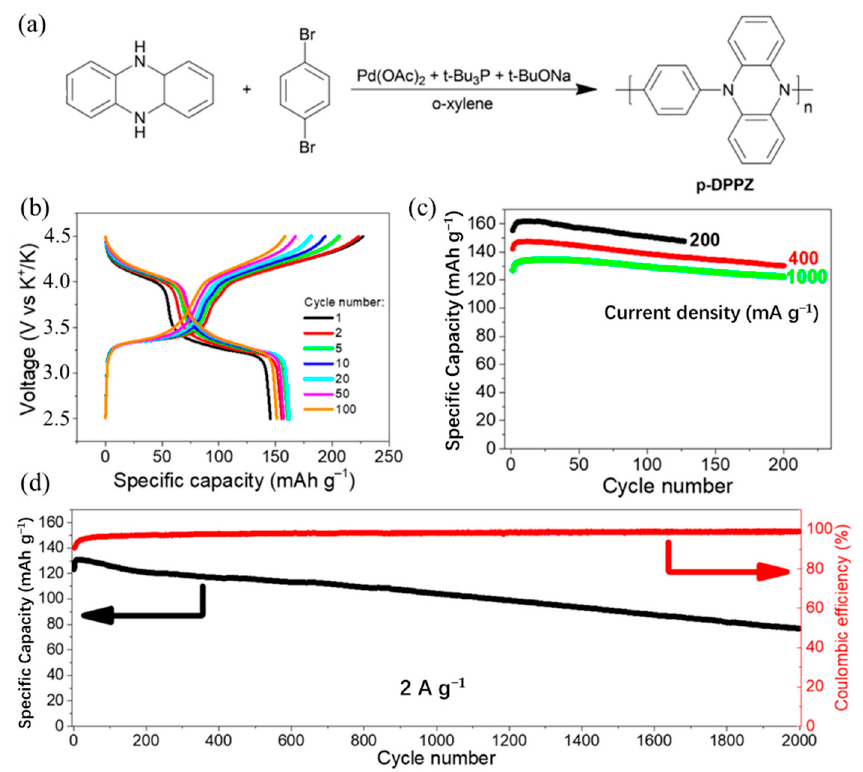
Figure 5. ( a ) The synthesis of p-DPPZ. ( b ) Charge and discharge characteristics of KIBs with p-DPPZ cathode and 2.2 M KPF 6 in diglyme electrolyte cycled in the voltage range of 2.5 − 4.5 V at 200 mA/g current density. ( c ) Evolution of specific capacity of KIBs with p-DPPZ cathode under cycling at different current densities. ( d ) Long-term cycling stability of cell at current density of 2 A/g. ( a – d ) Reproduced with permission from Ref. [61]. Copyright 2019 American Chemical